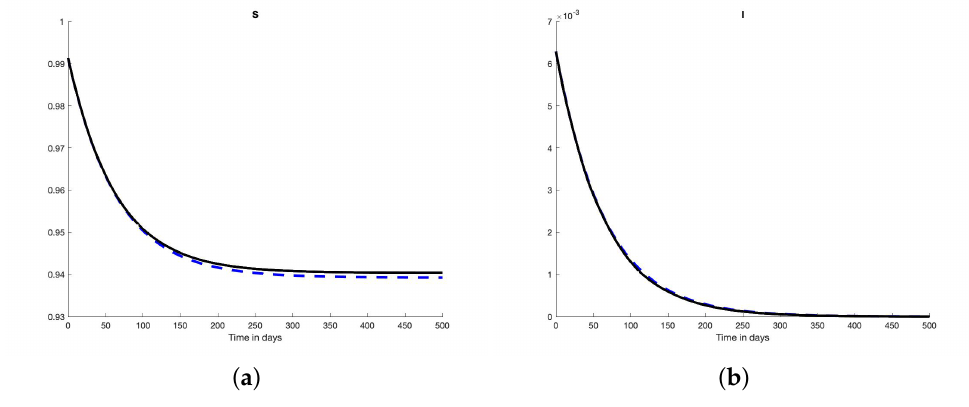
Figure 6. Scenario 3: States. ( a ) S and S ∗ (- -); ( b ) I and I ∗ (-